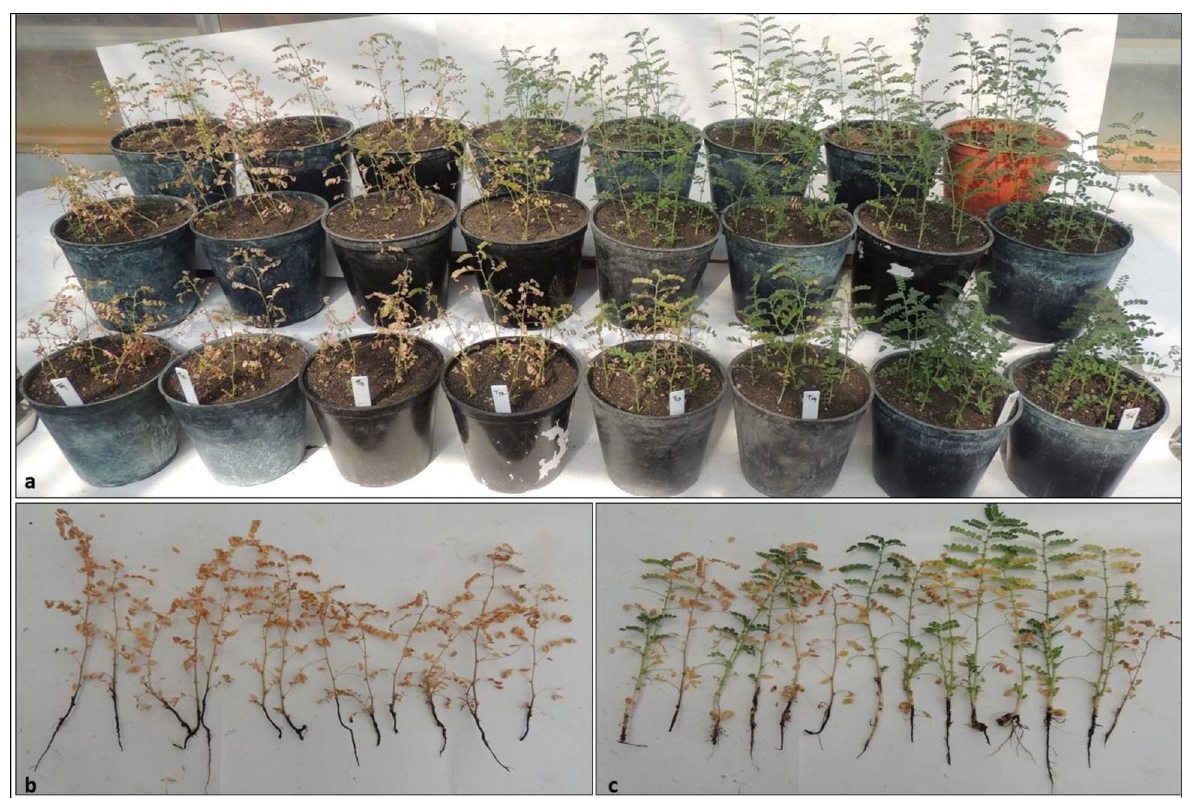
Fig 3. Integrated management of chickpea dry root rot disease under glasshouse condition. (a) Overview of the experiments at 44 days after sowing; (b) complete dry rot infected plants in T 1 (untreated) treatment; (c) partially dry rot infected plants in dry root rot in T 7 (N2-2+0.5 RD carbendazim) treatment at 60 days after sowing in JG 62 cultivar.